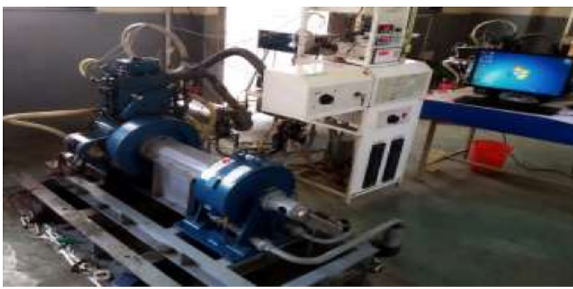
Figure 2. Illustrative interpretation of D.I Engine Arrangement.